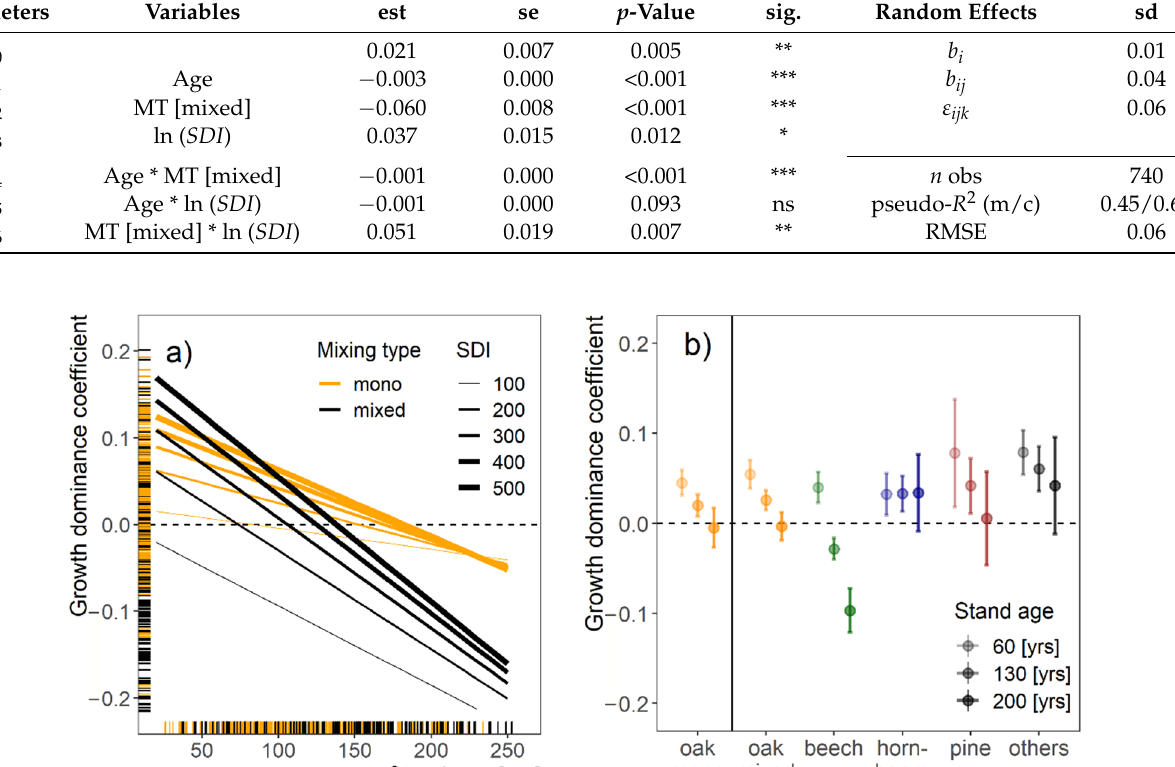
Figure 6. Growth dominance coefficient on stand level ( a ) in dependence of stand age and stand density for monospecific and mixed oak stands and the species-specific Growth dominance coefficient ( b ) for oak in monospecific and mixed stands, as well as beech, hornbeam pine and other tree species in dependence of the stand age; rugs on the x-and y-axis indicate the observed values of stand age and growth dominance coefficients, respectively; for the underlying model statistics see Table S3.